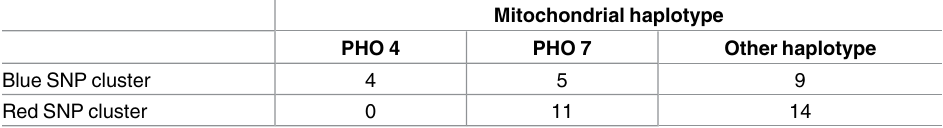
Table 6. Association between SNP Structure analysis-derived clusters for WBS to Baltic regions and mitochondrial haplotypes (cf. Fig 5 left panels–all samples). The haplotypedistribution between the two SNP clusters is significantly different ( Χ 2 = 6.111, p = 0.047 for all haplotypes), due to a significant difference in the occurenceof the haplotypes PHO4 and PHO7 ( Χ 2 = 6.111, p = 0.013 for PHO4/PHO7